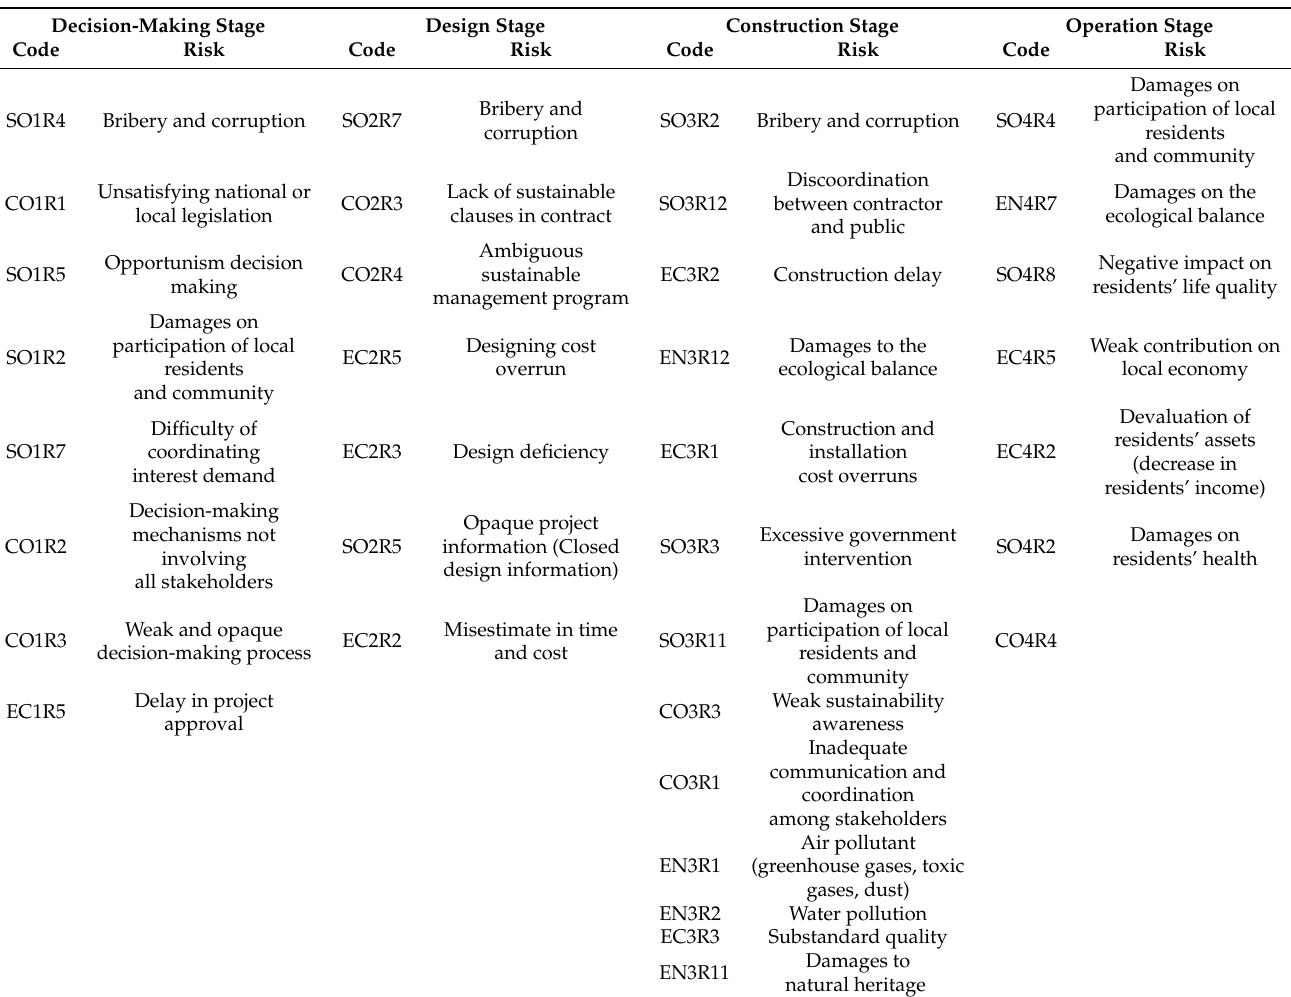
Table 8. The key risks of